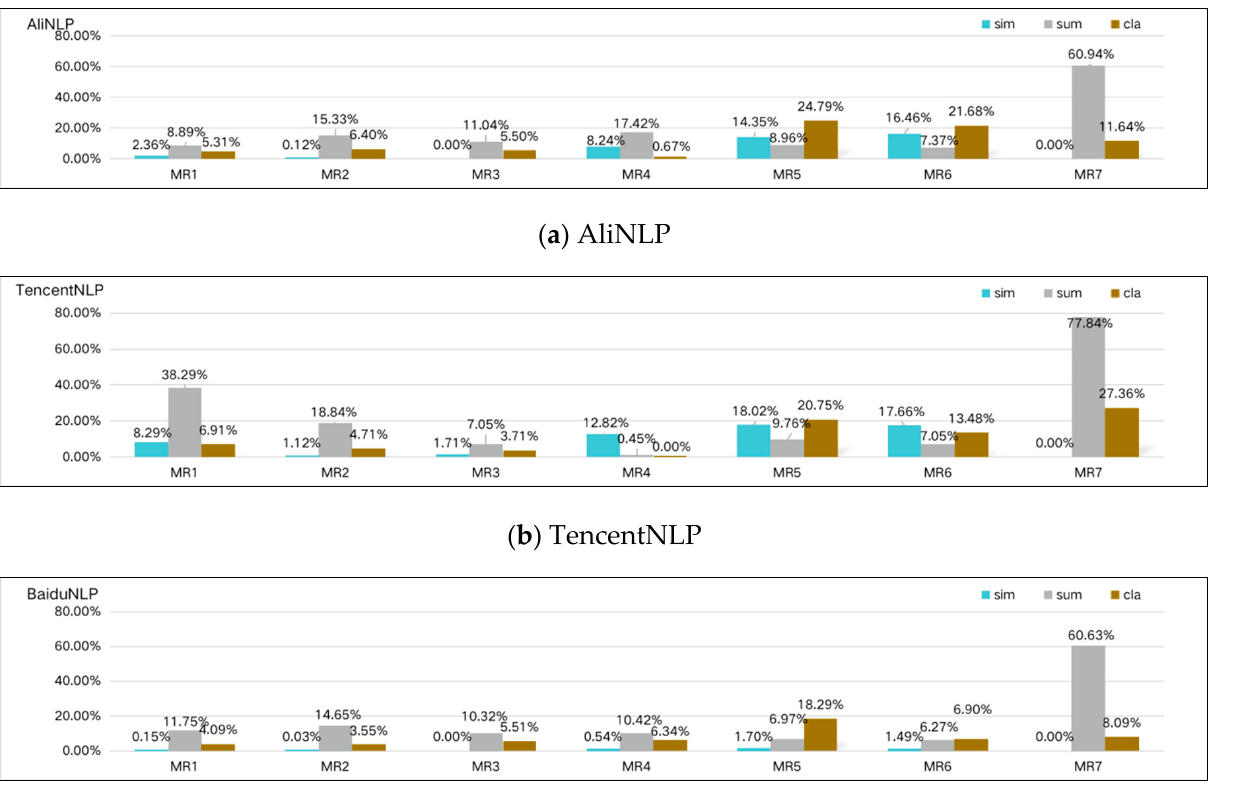
Figure 9. Results of each system in the MRP.